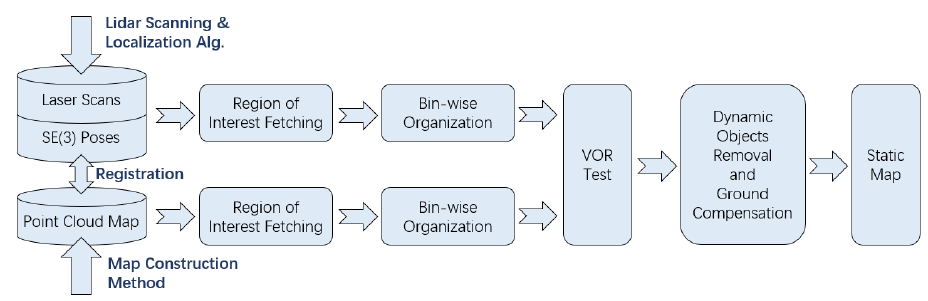
Figure 6. The pipeline of dynamic objects removal